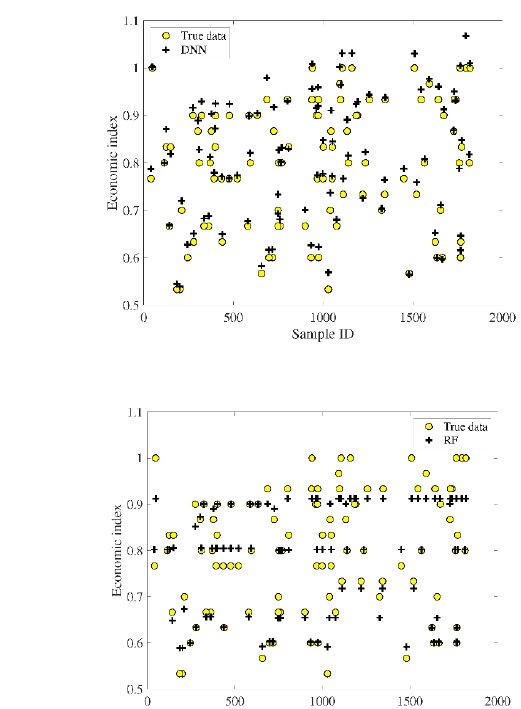
Figure 9. Comparison of the thrust variance prediction of the PMLM models built by proposed GAN and baseline methods.